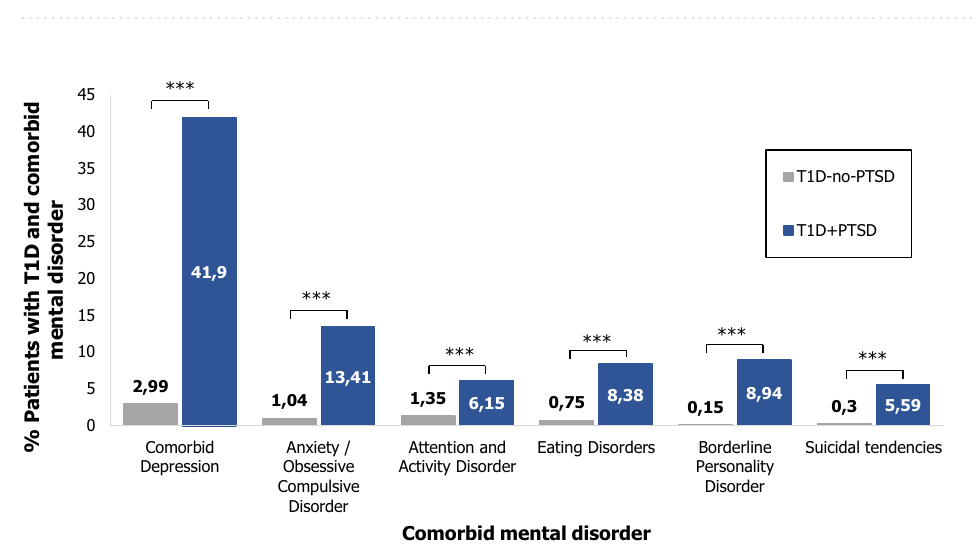
Figure 2. Mental comorbidities of patients with T1D and comorbid PTSD, compared to patients with T1D and no comorbid PTSD . All data are presented in percentage [%]. T1D type 1 diabetes, PTSD posttraumatic stress disorder, T1D + PTSD patients with T1D and posttraumatic stress disorder, T1D-no-PTSD patients with or without other mental comorbidities, not including PTSD; **significant (p < 0.01); ***significant (p <